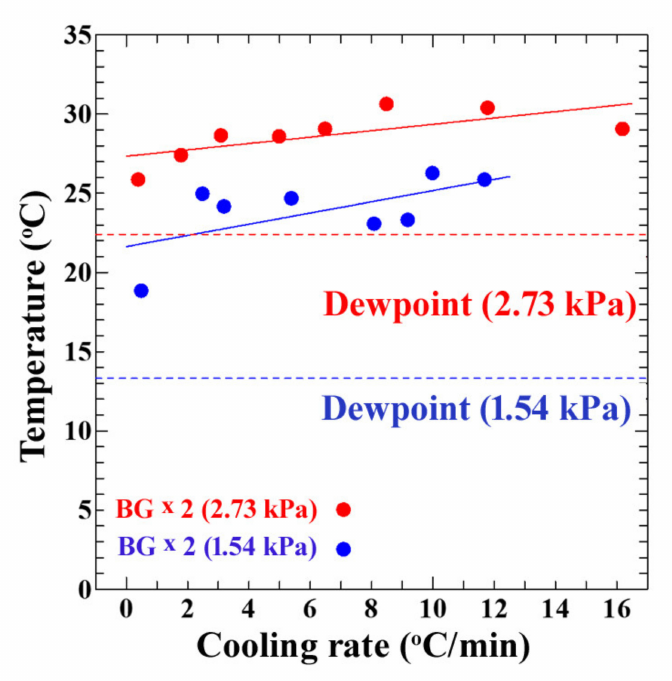
Figure 8. The temperature at which the sensor reached twice the background current as a function of the cooling rates of the sensor’s surface at 2.73 kPa (red data points) and 1.54 kPa (blue data points) vapor